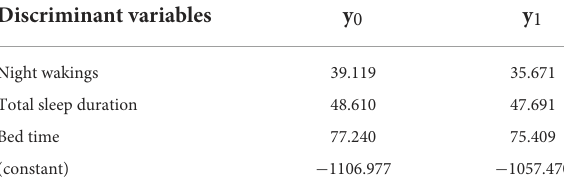
TABLE 10 Fisher function coefficients of 60–71 months age group.